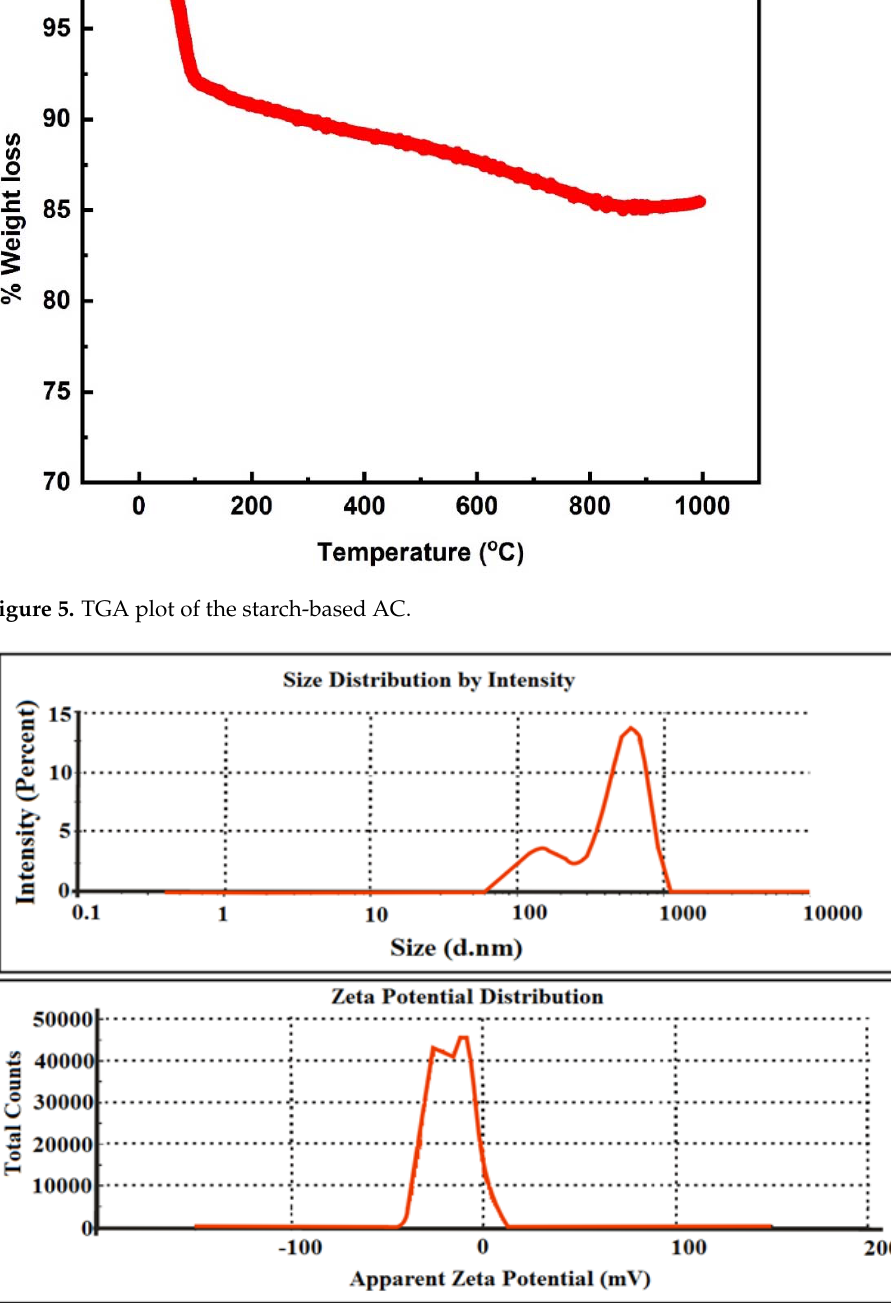
Figure 6. Zeta sizer and zeta potential of the starch-based AC.